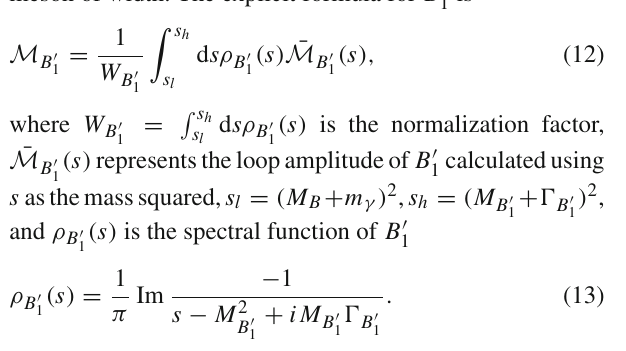
described by the Lagrangian